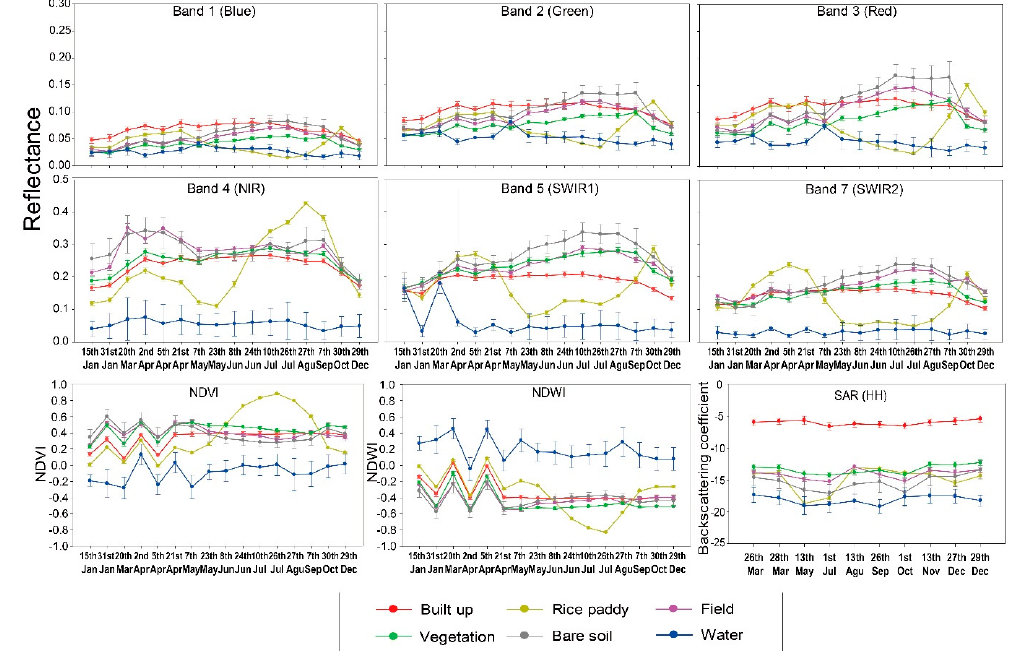
Figure 4. Phenological and spectral patterns of variables for each class (site A).